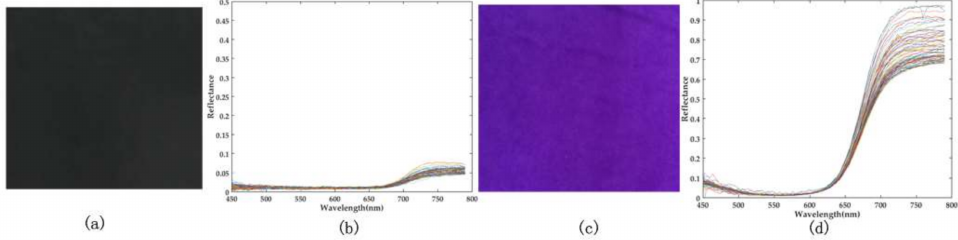
Figure 13. Black ( a ) and purple ( c ) backgrounds. The spectral data of the black background ( b ) and the purple background ( d ). The difference of reflectance between two backgrounds increases at 600 nm.